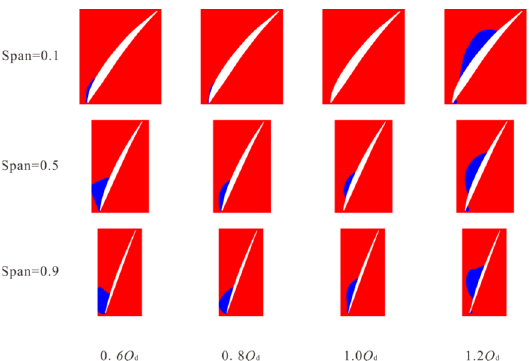
Figure 6. Pressure distribution of different blade heights below the threshold at different flow rates. (The blue area is below the pressure threshold and The red area is above the pressure threshold).